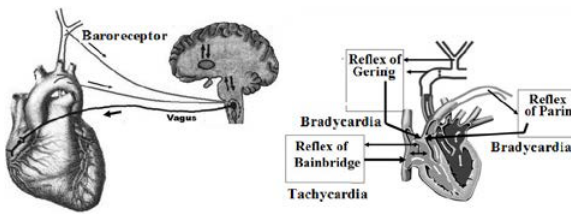
Fig. 7. Control of the rhythm of the sinoatrial node from the medulla oblongata of the central nervous system on the left, on the right, the control structure is shown using one's own cardiac reflexes. With an increase in blood pressure, the rhythm decreases. With a decrease in blood pressure, the rhythm